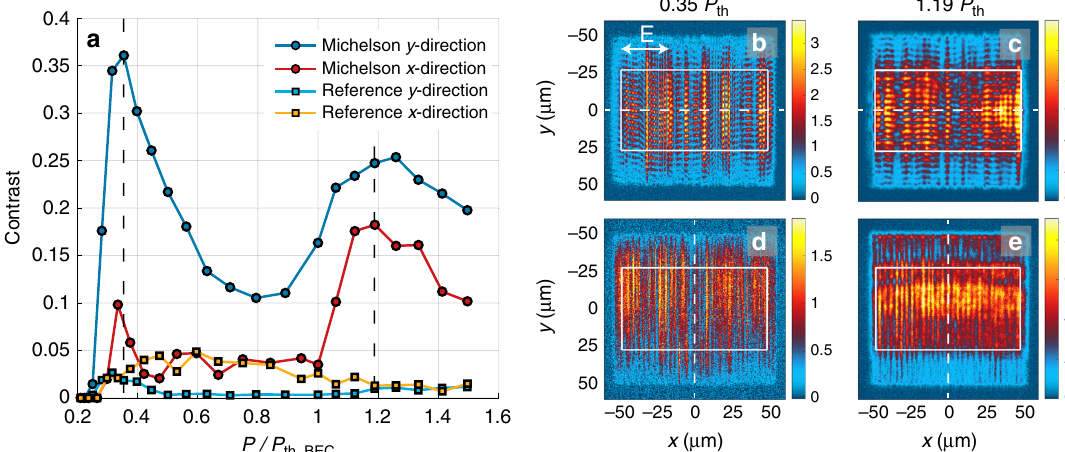
Fig. 4 Spatial coherence measurement along y - and x -axis of the plasmonic lattice. a The Michelson interferometer fringe contrast averaged over the region of interest (white boxes in b – e ) as a function of pump fl uence. For reference, the contrast is extracted also from non-interfered real space images, as light blue and yellow curves. b – e Interfered real space images, where one of the images is inverted with respect to the white dashed line, to obtain the spatial coherence between − y and + y positions ( b , c ) or − x and + x positions ( d , e ). The interference patterns are shown for pump fl uences corresponding to the lasing and condensation regimes (dashed lines in a ). To obtain the spatial coherence between − x and + x positions, instead of rotating the detection optics, we rotate the sample (the lattice) and pump polarization by 90 ∘ . The vertical stripes in b and d are due to one-dimensional lasing in y -direction, while the horizontal stripes (fringes) in b , c and vertical in e arise from spatial coherence in the overlapped images in the Michelson interferometer. For more details see Methods (Spatial coherence measurements) and Supplementary Note 4. The real space images are recorded for single pump